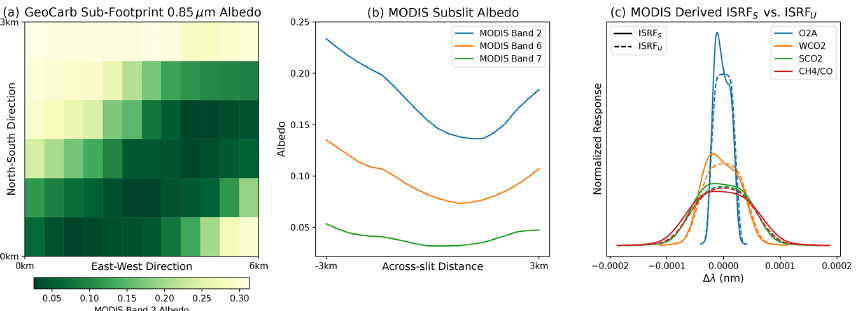
Figure 1. Variation in MODIS Band 2 (0.85µm)-observed 500m black-sky albedo for a single GeoCarb footprint (a) ; Band 2, Band 2 (1.64µm), and Band 7 (2.1µm) albedos averaged in the N–S direction (b) ; and the resultant normalized ISRFs for the center wavelength in each of the four GeoCarb bands in Table 1 (c) . ISRF S denotes the ISRF computed from (Eq. 1) with the illumination profile in the center panel, while ISRF U uses a flat illumination profile. In this figure, the Band 7 albedo was used for the CH 4 –CO band for simplicity. MODIS data demonstrate variation for a representative GeoCarb footprint near the southern Great Plains (SGP) research facility near Lamont, Oklahoma, on 18 June 2014.